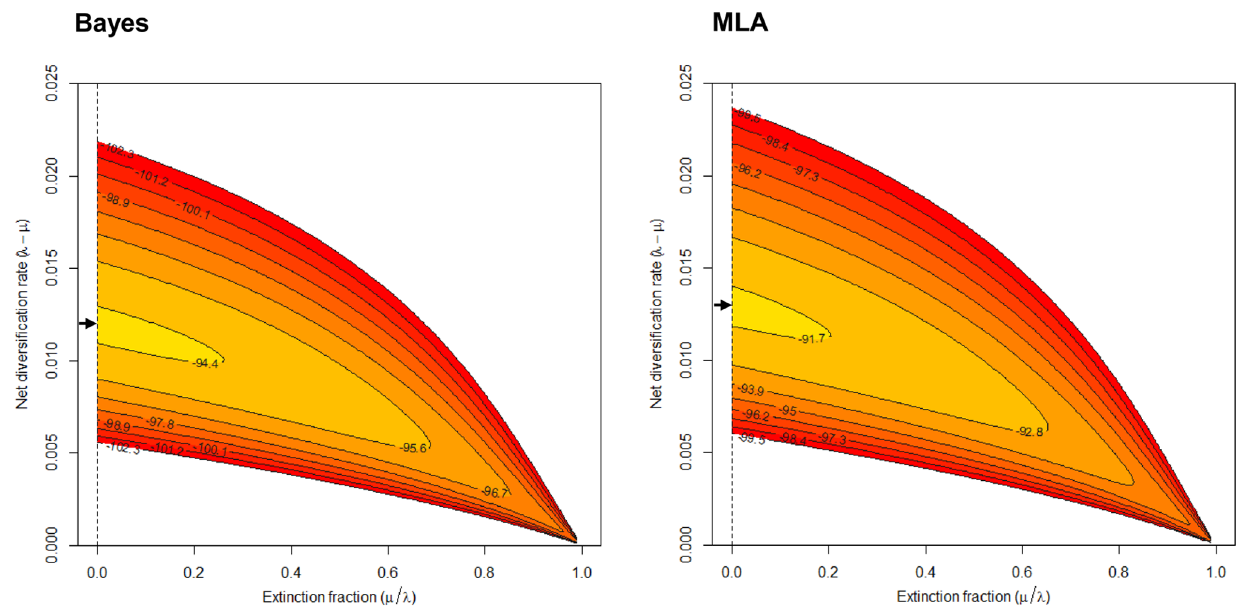
Figure 8. Contour plots of the likelihood surfaces. Contour plots of the likelihood surface were inferred from the relation between the net diversification rate ( l – m ) and extinction fraction ( m / l ) for the Bayes (left) and MLA (right) chronograms. Likelihoods were calculated using the R package LASER. The maximum likelihood estimates (i.e., the peak of the surface) are marked with an arrow.